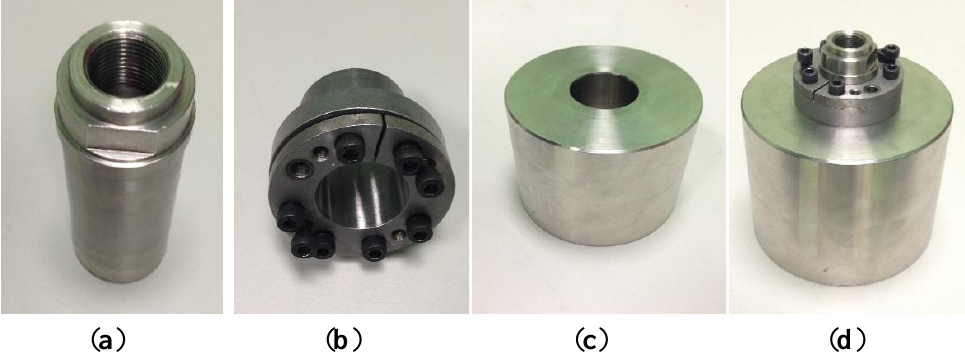
Figure 11. The figure represents the two parts of the pressure coupling element, ( a ) and ( b ), one large cylindrical loading mass, ( c ), and the whole assembly, ( d